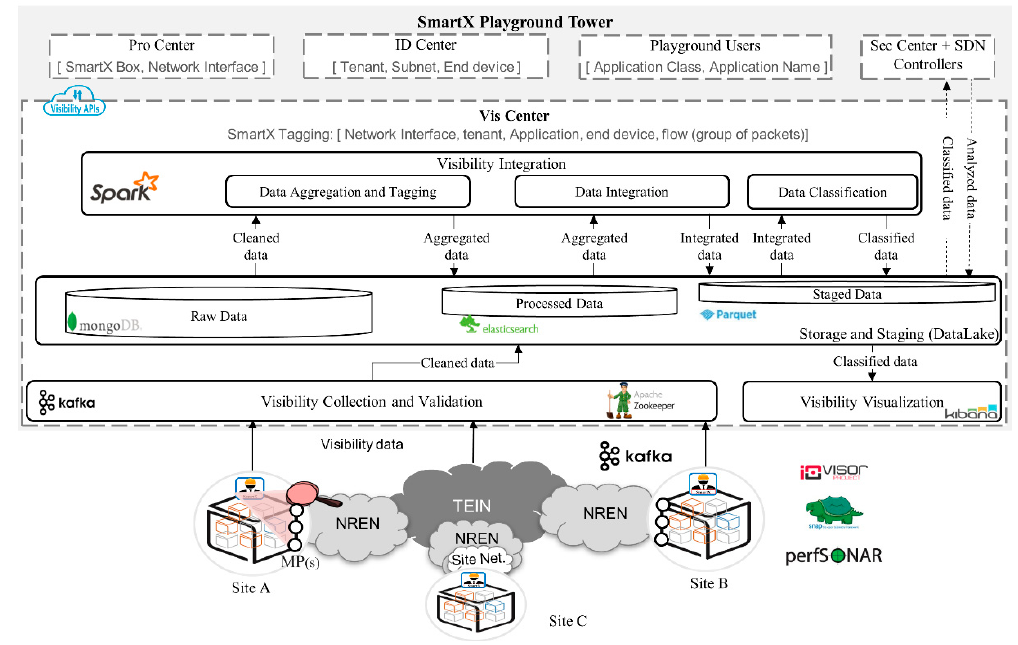
Figure 3 . The overall architecture of SmartX MVF with the extension of flow-centric visibility. Figure 3. The overall architecture of SmartX MVF with the extension of flow-centric